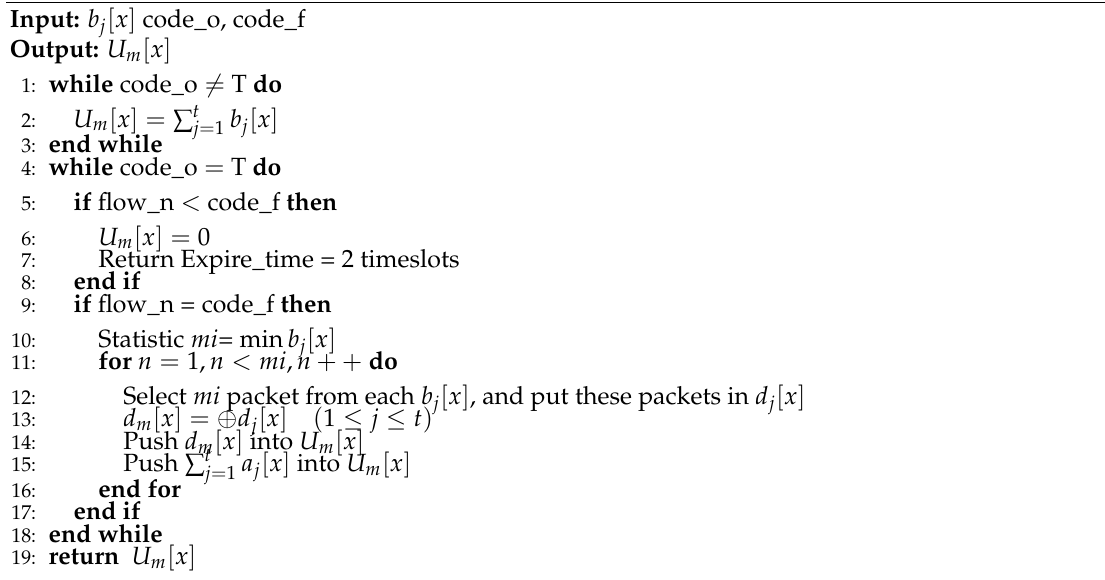
Algorithm 1 Encoding algorithm in each